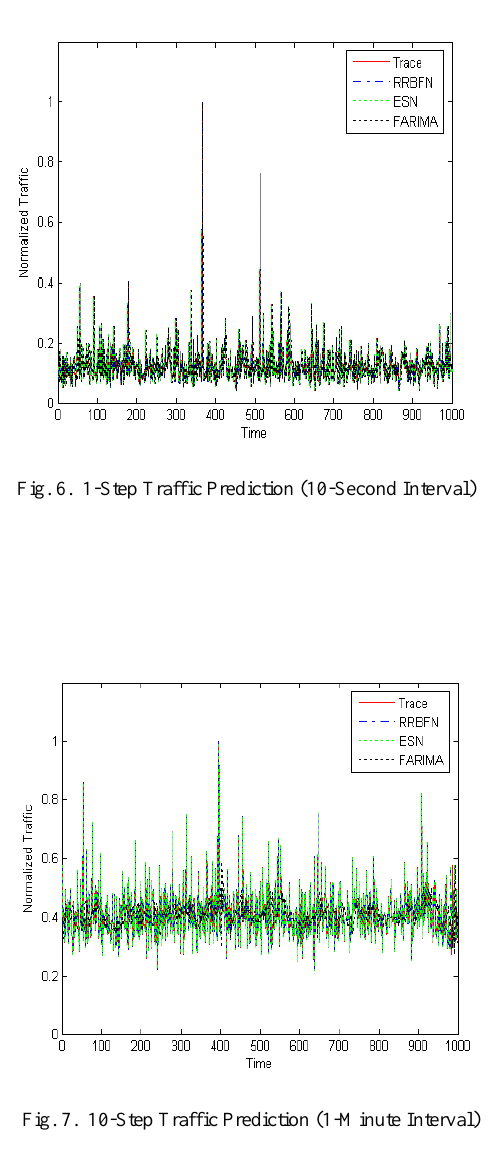
Complementary-CDF (CCDF), plot for trace and